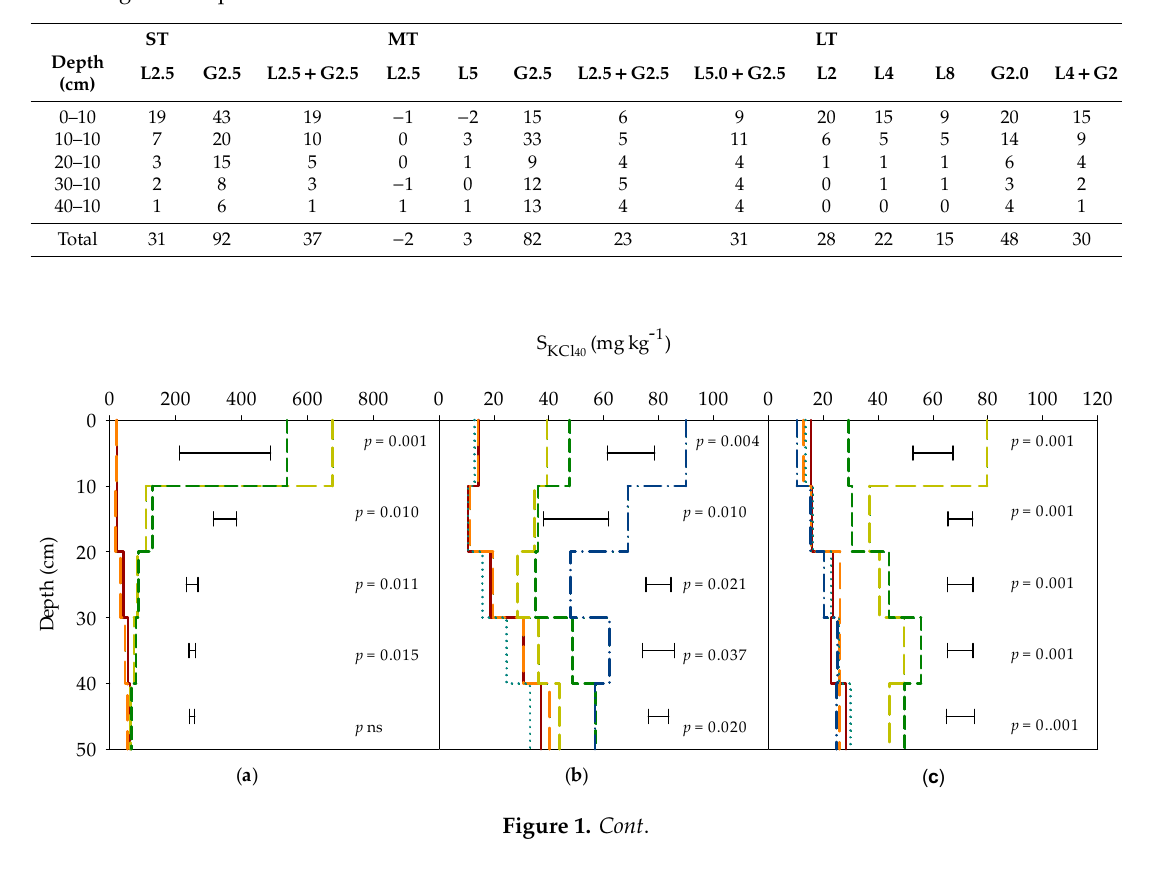
Table 2. Recovery (%) of the applied Ca from the L and G application as calculated by the difference in Ca Ex between the L and G treatments compared to the C treatment for the ST, MT, and LT experiments using soil samples collected in March 2018.